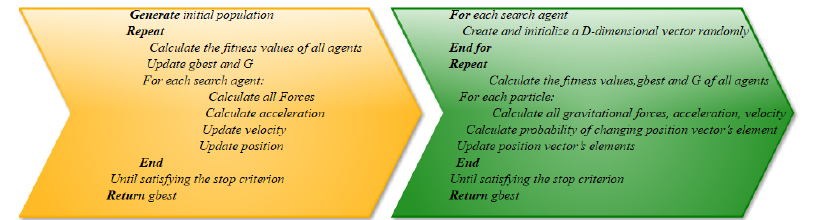
Figure 6. Pseudocode of